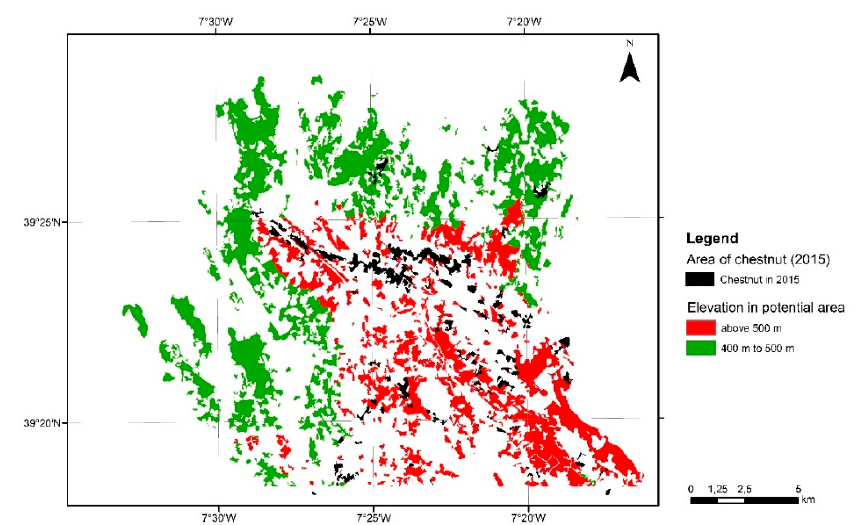
Figure 6. Current chestnut area and distribution of the potential expansion area by altitude.